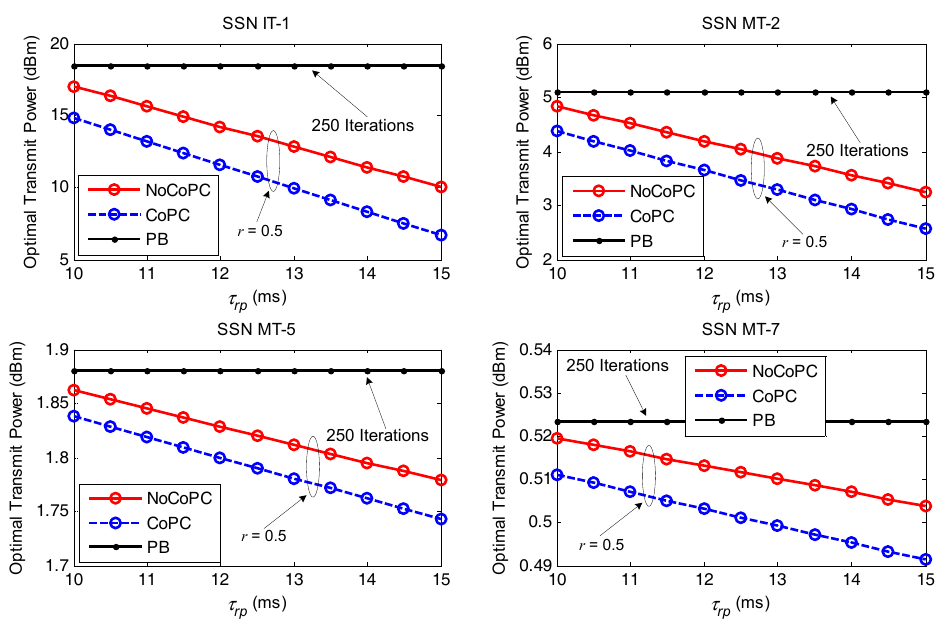
τ ( r = 0.5, l = 250 iterations). NoCoPC: Figure 9. Optimal transmit power vs. the slot Figure 9. Optimal transmit power vs. the slot τ rp ( r = 0.5, l = 250 iterations). NoCoPC: noncooperative rp power control; CoPC: cooperative power control; PB: power noncooperative power control; CoPC: cooperative power control; PB: power balancing.